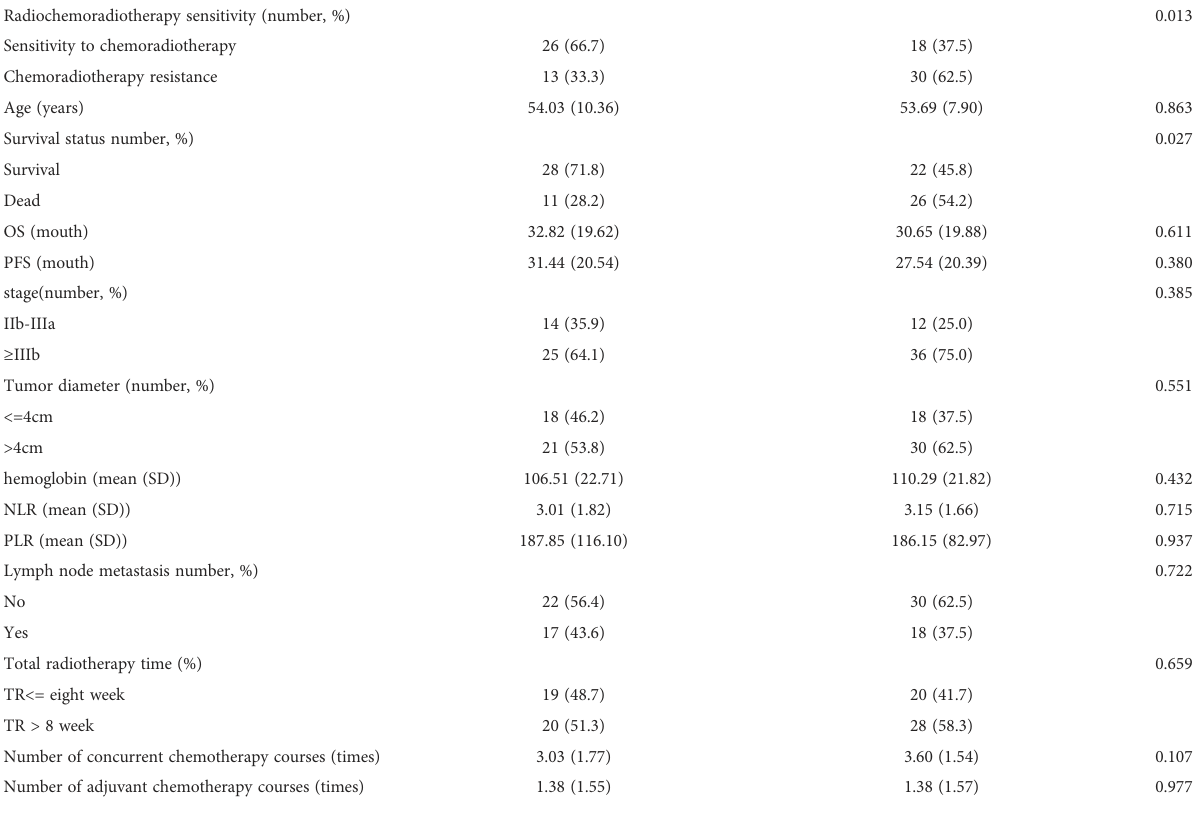
TABLE 3 General characteristics of the patient. Clinical